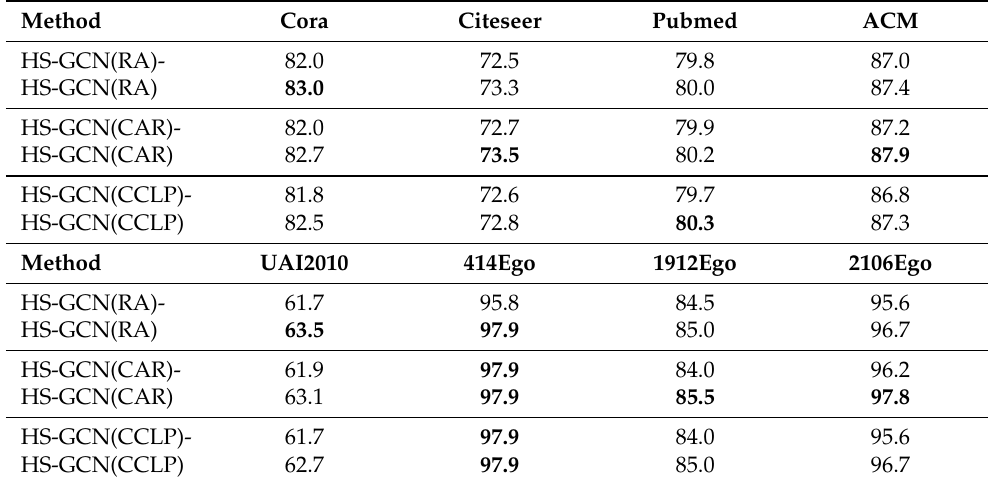
Table 3. The results (max %) of node classification for each high order similarity method. (Bold: best performance for each dataset).